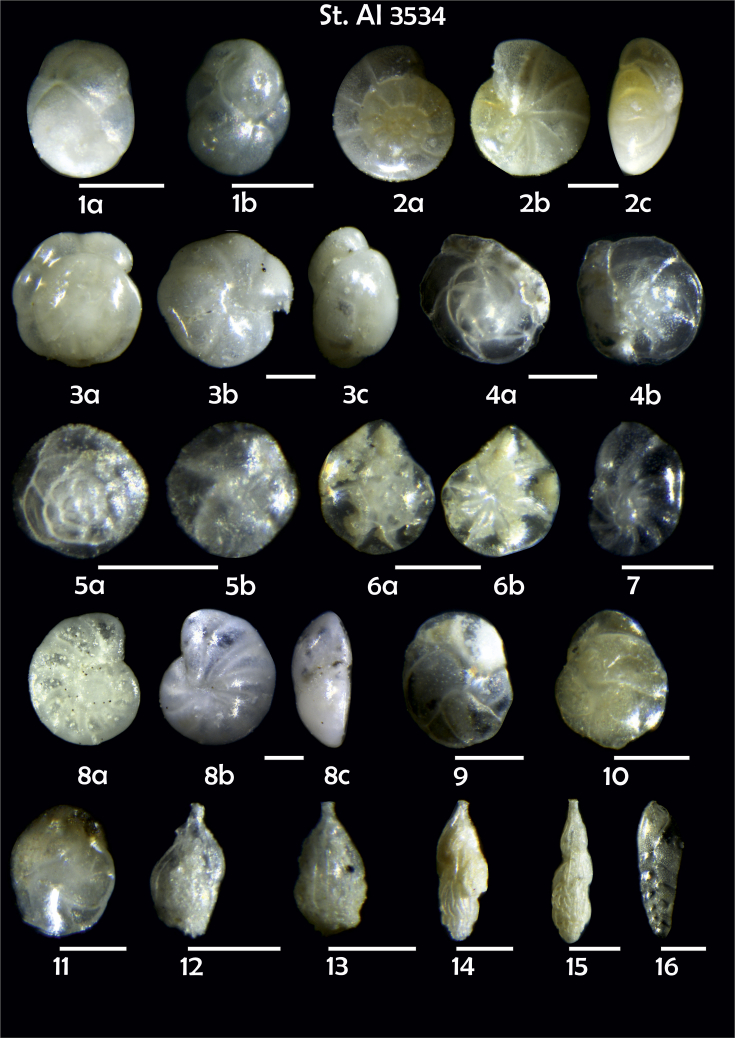
Station 35341Globacassidulina subglobosa, a, lateral view, b apertural view. 2Gyroidina orbicularis, a spiral view, b umbilical view, c apertural view. 3Oridorsalis umbonatus?, a spiral view, b umbilical view, c apertural view. 4Gavelinopsis praegeri,a spiral view, b umbilical view. 5Alabaminella weddellensis, a spiral view, b umbilical view. 6Epistominella exigua,a spiral view, b umbilical view. 7Nonionella auricula. 8Cibicidjides lobatulus?, a umbilical view, b spiral view. 9, 10Cassidulina laevigata. 11C. teretis. 12, 13, 14, 15Trifarina angulosa. 16Bolivina earlandi. Scale 100 μm.